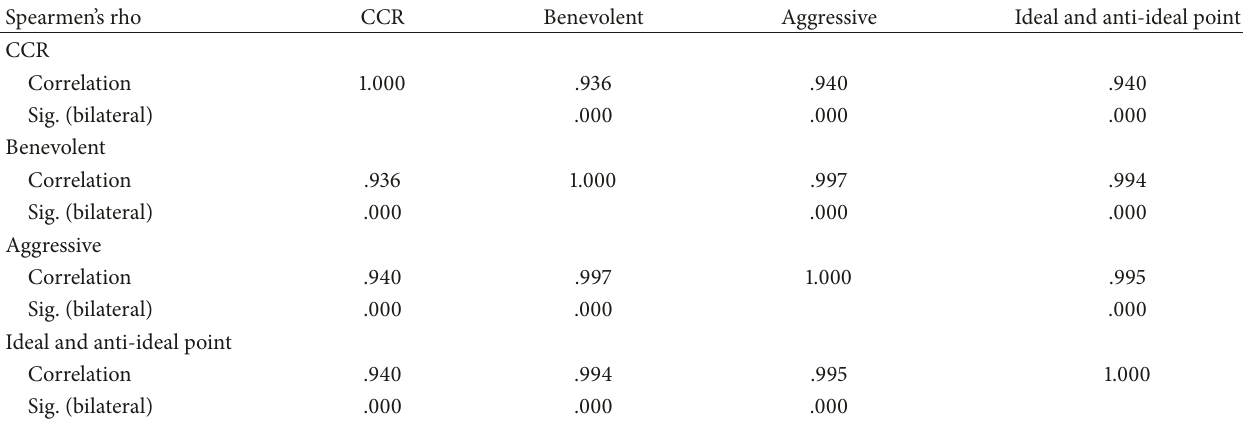
Table 6: DEA efficiency correlation